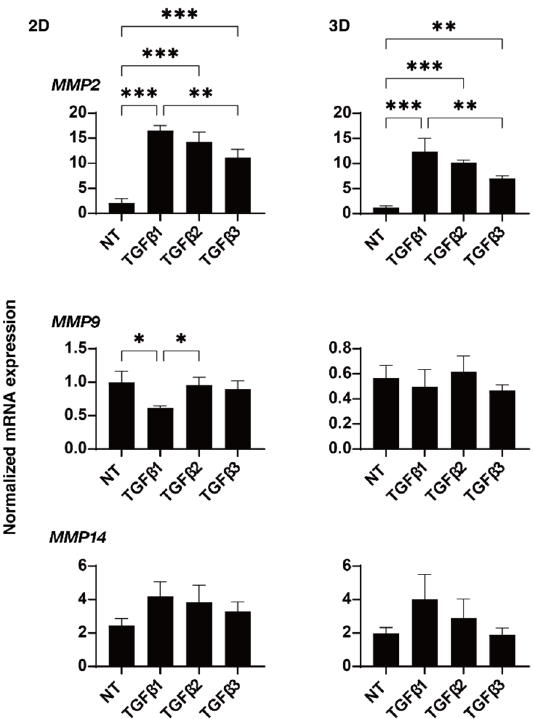
Figure 6. Effects of TGF ‐β isoforms on the mRNA expression of TIMPs in 2D ‐ and 3D ‐ cultured HTM cells. At day 6, 2D ‐ and 3D ‐ cultured HTM cells (NT, non ‐ treated control) and cultures treated with 10 ng/mL TGF ‐β‐ 1, 5 ng/mL TGF ‐β‐ 2, or 1 ng/mL TGF ‐β‐ 3 were subjected to qPCR analysis to estimate the expression of mRNA in TIMP1–4. All experiments were performed in triplicate each using freshly prepared 2D HTM cells and 3D HTM spheroids (n = 15–20, total 45–60) in each experimental condition. * p < 0.05; ** p < 0.01.